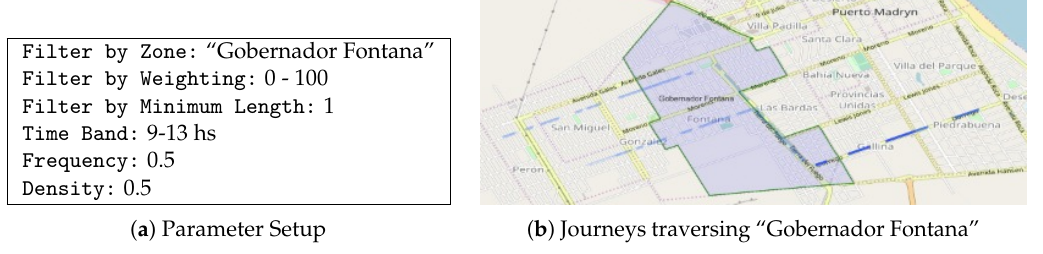
Figure 5. Experiment setup and